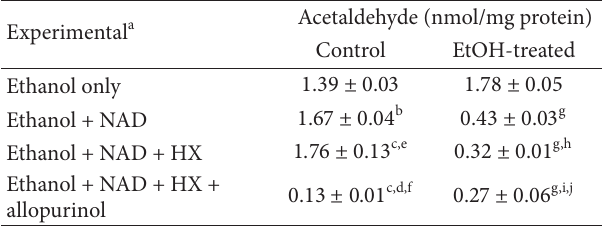
Table 3: Ethanol metabolism to acetaldehyde in the cytosolic fraction of uterine horn tissue from rats receiving an alcohol containing liquid diet.